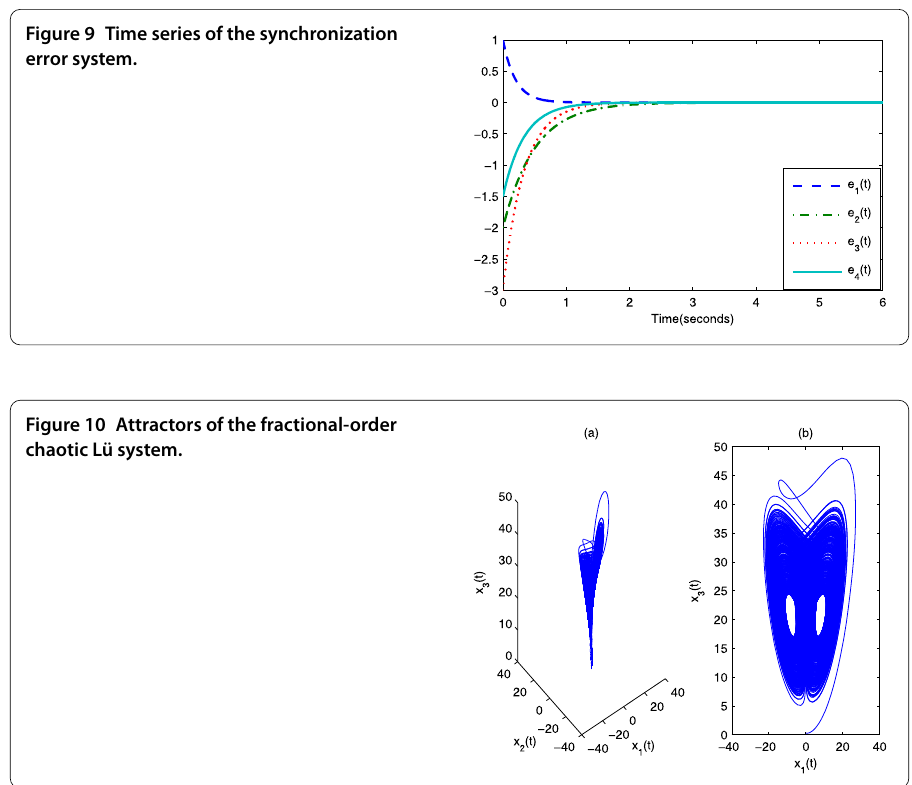
Figure 9 Time series of the synchronization error system.